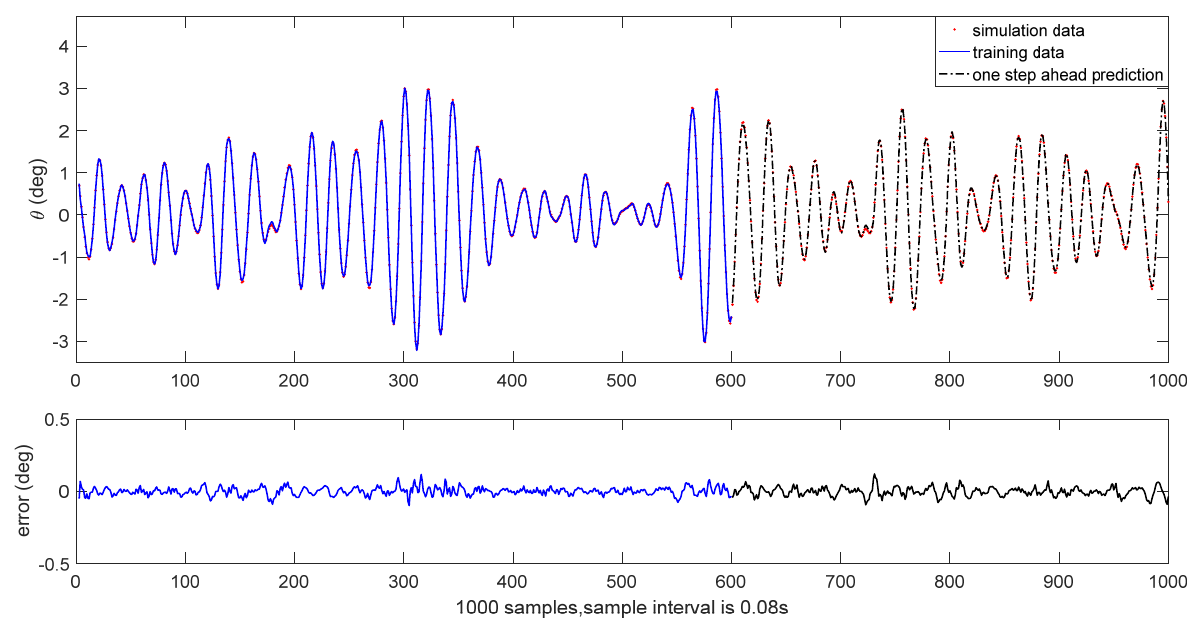
Figure 14. The one-step ahead prediction of heave motion in irregular waves for the FPSO model.